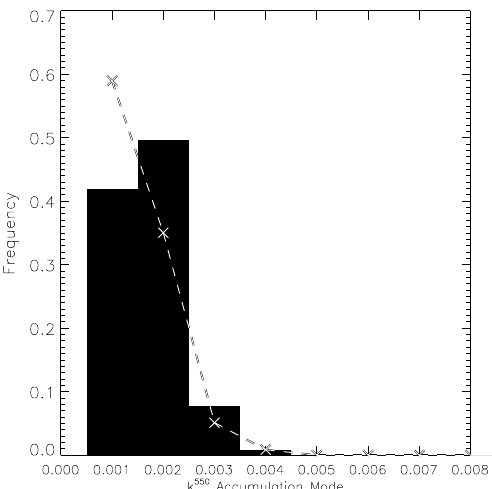
Fig. 9. Histogram showing derived k550 values for the accumu- lation mode for horizontal legs during Fennec. Solid bars show derivations using size distributions corrected using k 550 = 0 . 001 i , dashed line and crosses show derivations using size distributions corrected using k 550 = 0 . 003 i